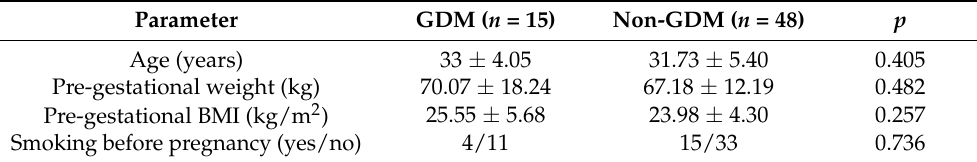
Table 1. Baseline characteristics of study participants. Parameter